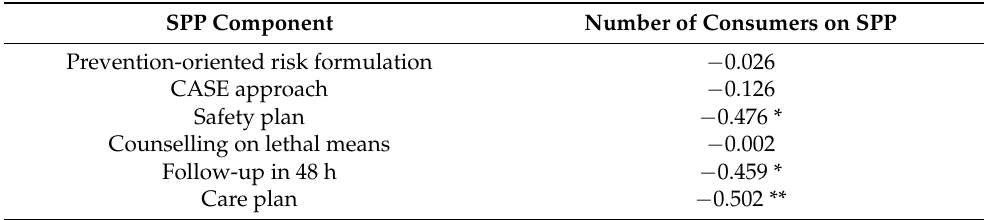
Table 1. Pearson correlation coefficient between number of SPP placements and completion of SPP components by the Acute Care